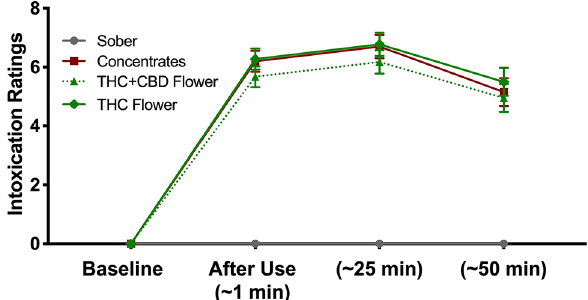
Figure 3. Intoxication ratings across groups over time. Lines represent mean intoxication ratings before, immediately after, 25 min after, and 50 min after inhaling cannabis in the four groups. Error bars represent standard errors of the mean. Results revealed significant main effects of time, F (3,228) = 261.59, p < .001, η 2 p = .77, and group, F (3,76) = 73.15, p < .001, η 2 p = .74, as well as a significant time x group interaction, F (9,228) = 29.32, p < .001, η 2 p = .54. Follow-up one-way within-groups ANOVAs revealed no change in intoxication ratings over time in the sober control group (they consistently remained at 0). In contrast there were significant changes in intoxication ratings in the THC flower group, F (3,57) = 106.52, p < .001, η 2 p = .85, THC + CBD flower group, F (3,57) = 73.27, p < .001, η 2 p = .79, and concentrates group, F (3,57) = 85.51, p < .001, η 2 p = .82. Post hoc comparisons revealed that for all three cannabis-using groups intoxication ratings significantly increased from before cannabis use to all three time points after use ( p s < .001). There were also small but significant decreases in these ratings from 25 to 50 min after use ( p s ≤ .001) in the three cannabis-using groups. Intoxication ratings at baseline were 0 for all participants in all groups. There were significant differences in the four groups’ intoxication ratings p < .001, η 2 p = .73, and 50 min after use, F (3, 76) = 30.41, p < .001, η 2 p = .55. Further post hoc comparisons